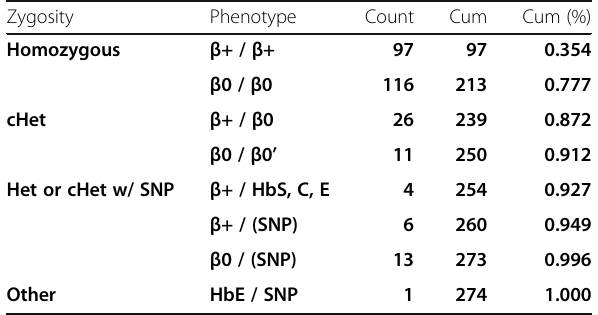
Table 4 Configuration of Observed β -Thalassemia Mutations